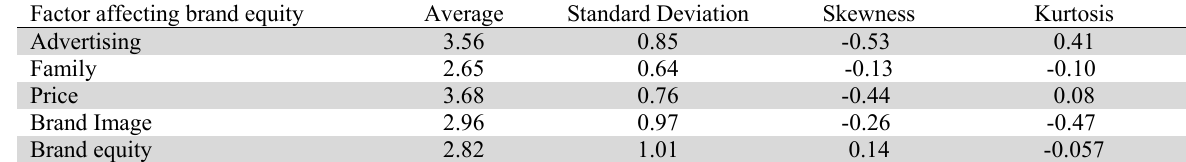
Skewness and kurtosis statistics for Factors affecting brand equity and brand equity Factor affecting brand equity